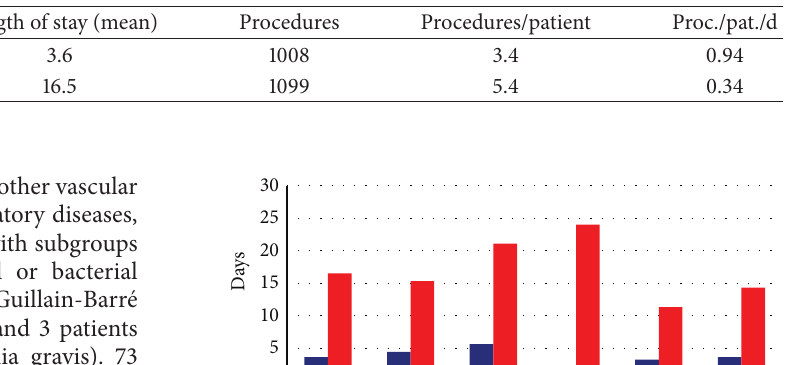
Table 2: Procedures/pat./day.